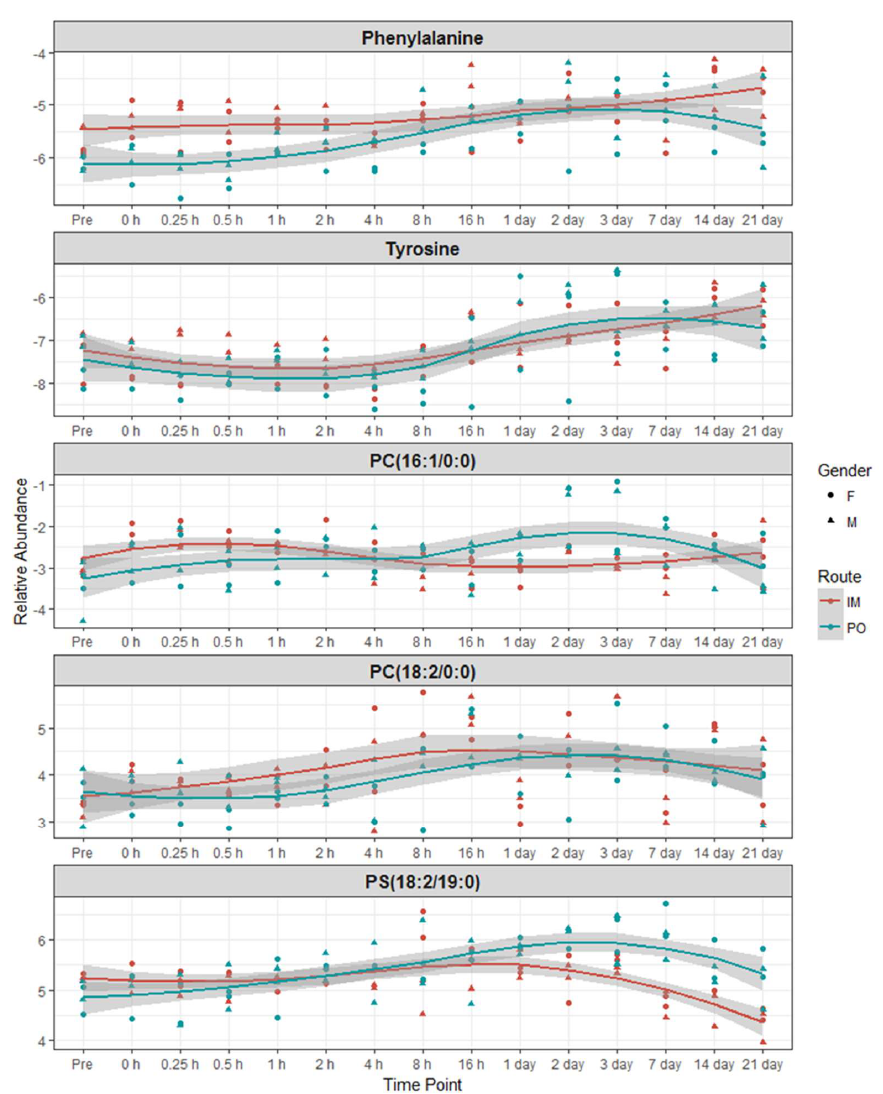
Figure 3. ANOVA analyses help delineate metabolites showing a common trend following each route of administration.